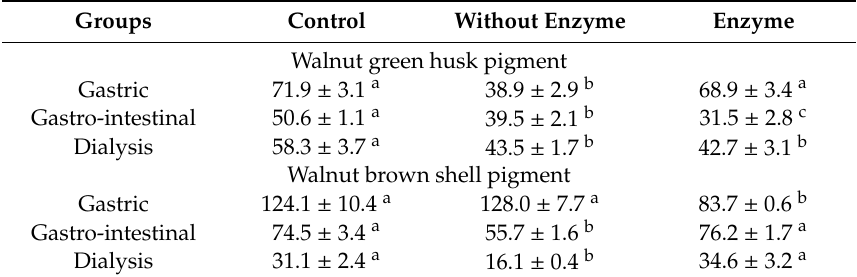
Table 2. The ferric-reducing antioxidant power (FRAP) of walnut green husk and brown shell pigment subjecting to simulated in vitro digestion and dialysis ( µ mol TE /